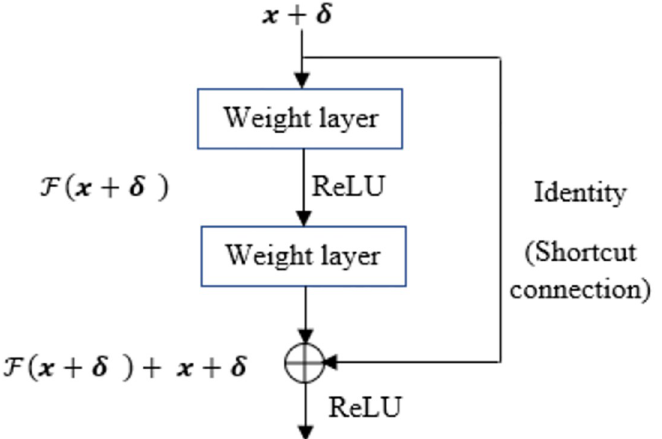
Fig 2. A residual block (RB) in ShapAAL with perturbed